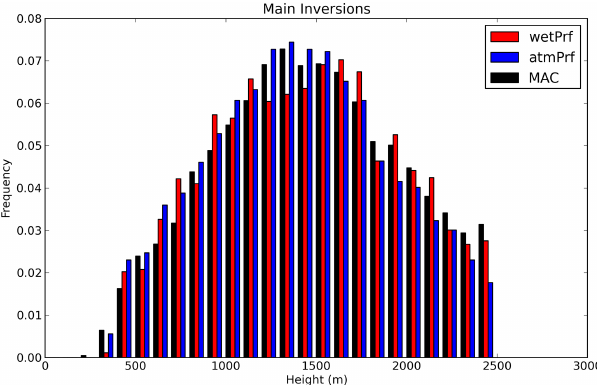
Figure 6. Main refractivity break point for MAC (black), COSMIC wet (red), COSMIC raw (blue).